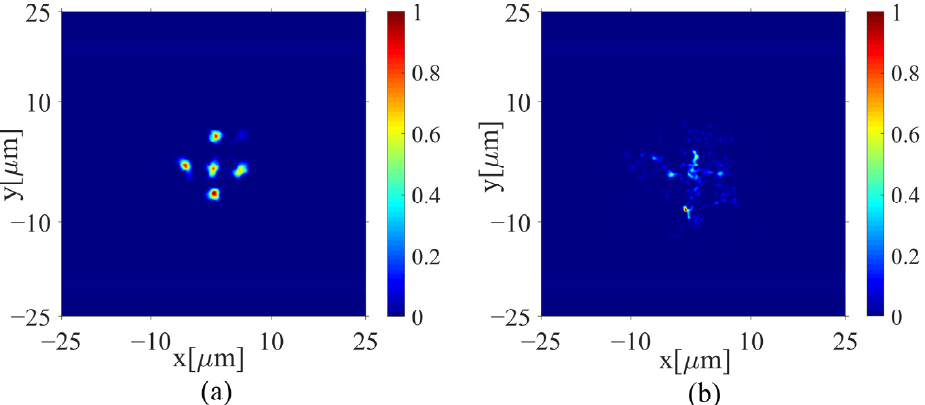
Figure 7. Optical field distribution of the novel G-DOF at ( a ) the doped regions and ( b ) the undoped regions.